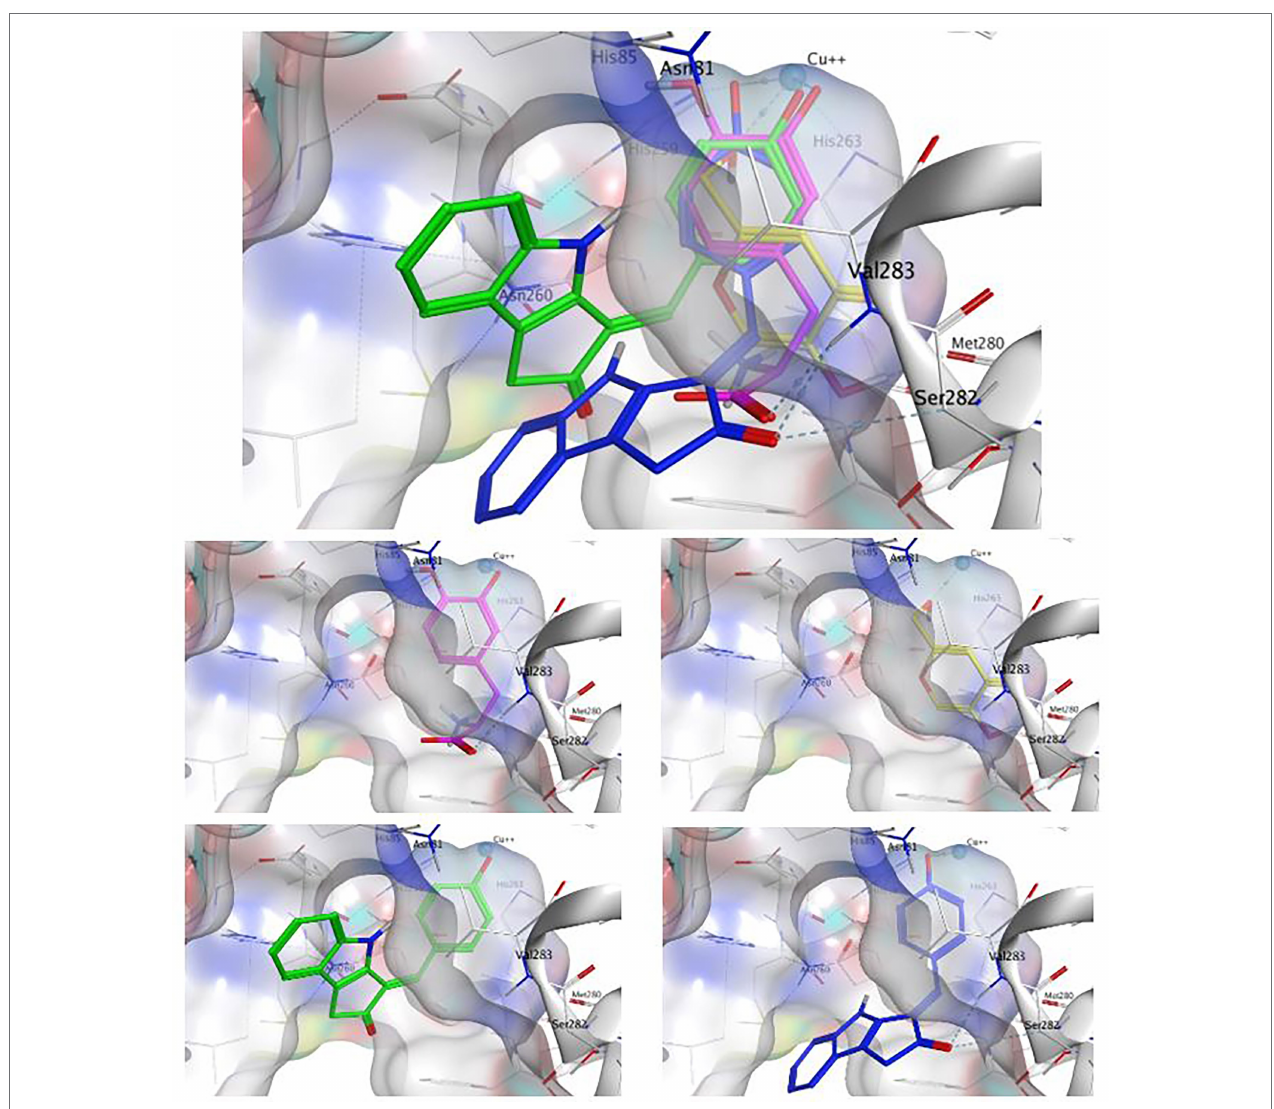
FIGURE 7 | The binding conformation of l -DOPA (magenta), kojic acid ( 3 , yellow), ScyM with best binding score ( 1 , green) and ScyM with second-best binding score ( 1 , blue). Sub-panels are provided for each individual compound to better show their interaction with nearby residues. The cyan sphere represents the copper ion in contact with ligands in substrate binding pocket. Blue colored dashed lines represent hydrogen bonds formed between ligand and corresponding tyrosinase residues. Dockings of various ligands were performed separately but assembled together in the composite figure for visualization of spatial